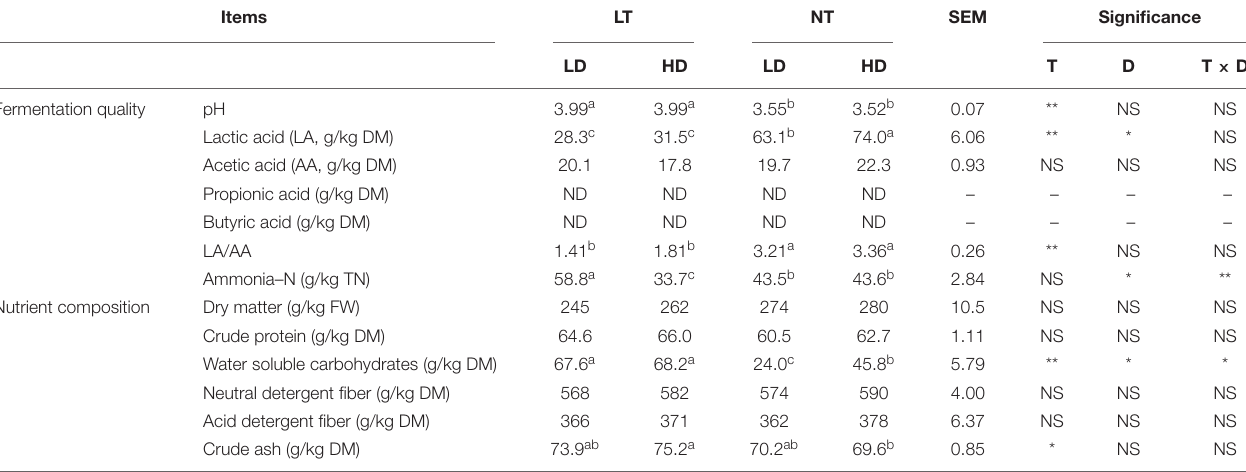
TABLE 2 | Fermentation quality and nutrient composition of sorghum-sudangrass silage ( n = 3). Items LT NT SEM